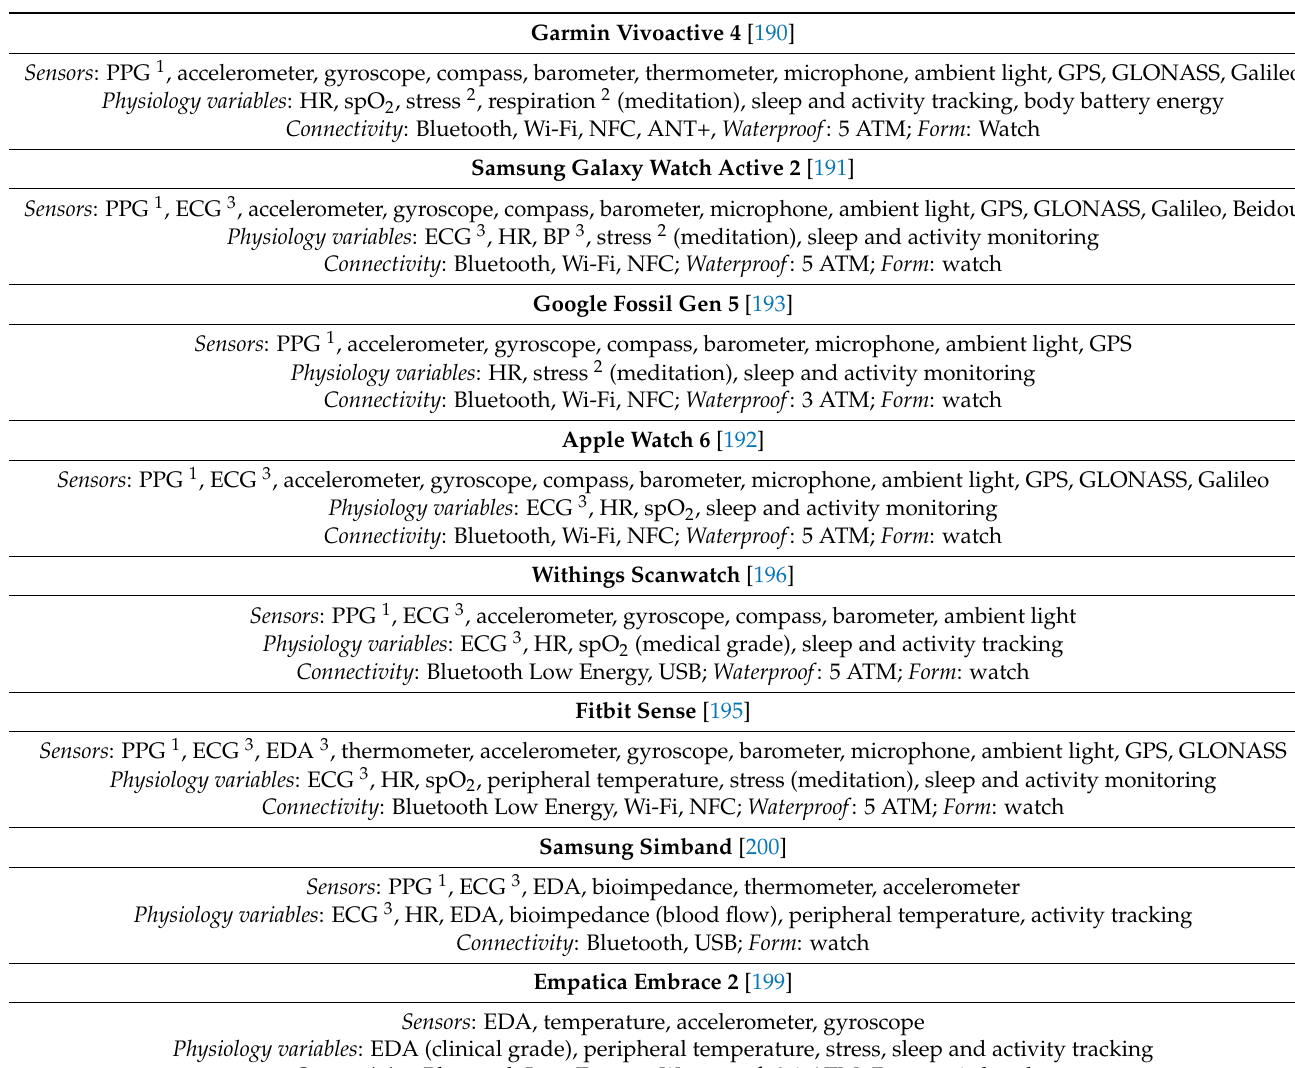
Table 1. Technical parameters of selected wearable devices suitable for